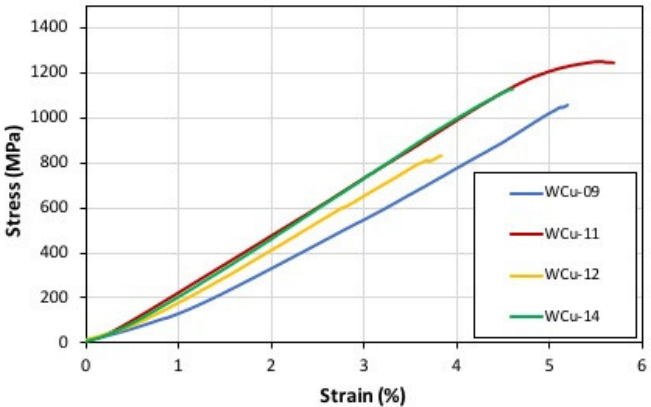
Figure 4. The experimental results of W-Cu specimens in accordance with ASTM E9.